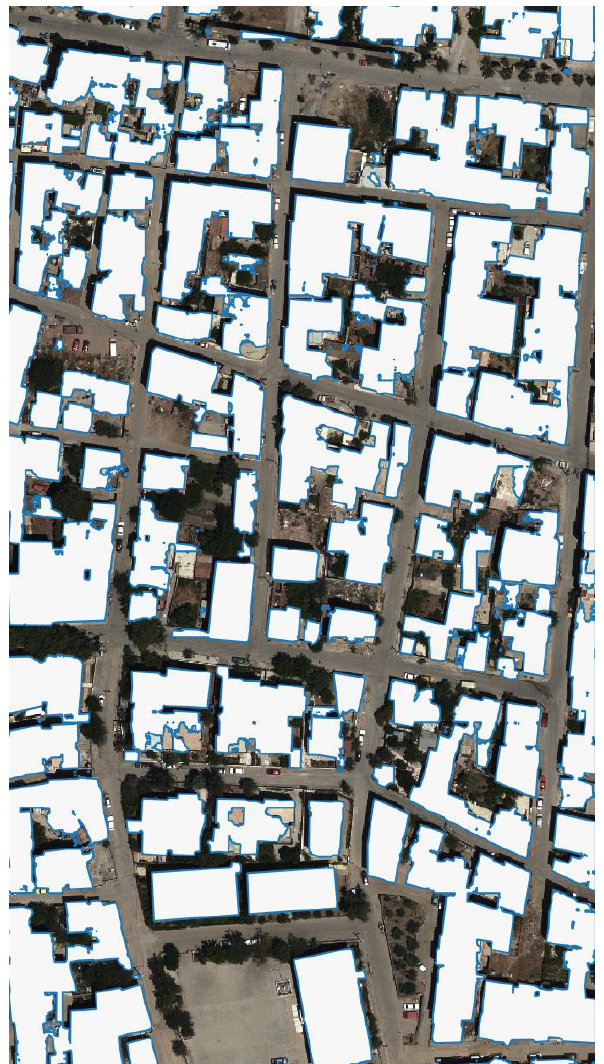
Figure 6. A close view of generated building footprints from the test